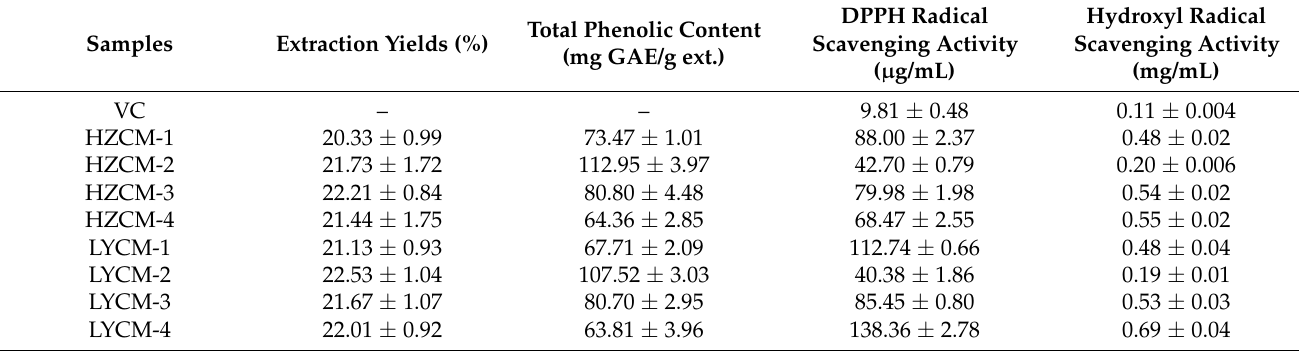
Table 1. Extraction yields, total phenolic contents, and antioxidant activities (IC 50 values) of the Cortex Moutan extracts.